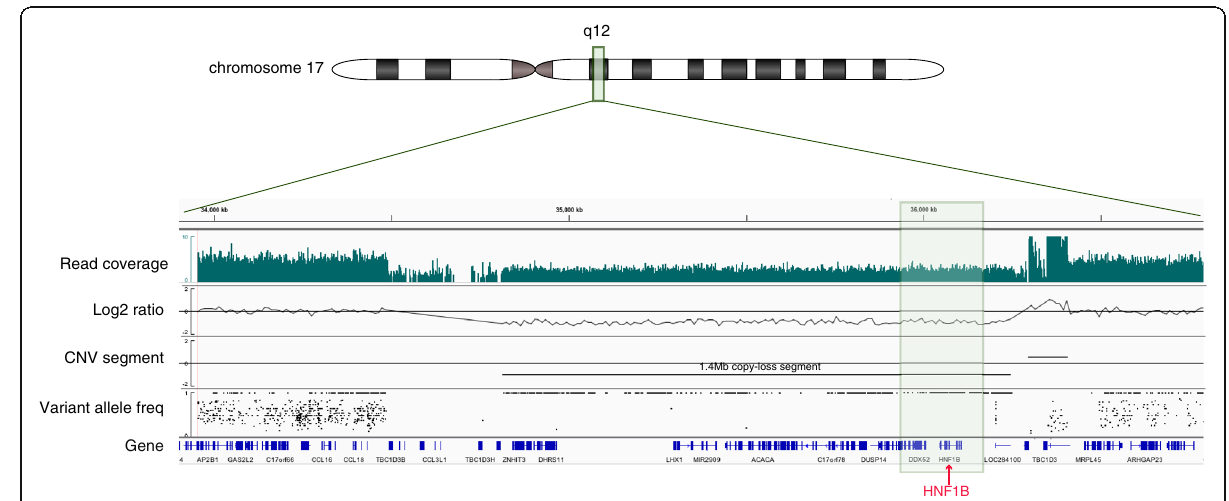
Fig. 3 HNF1B deletion in a MODY patient. Copy number analysis of MODY sample MDX